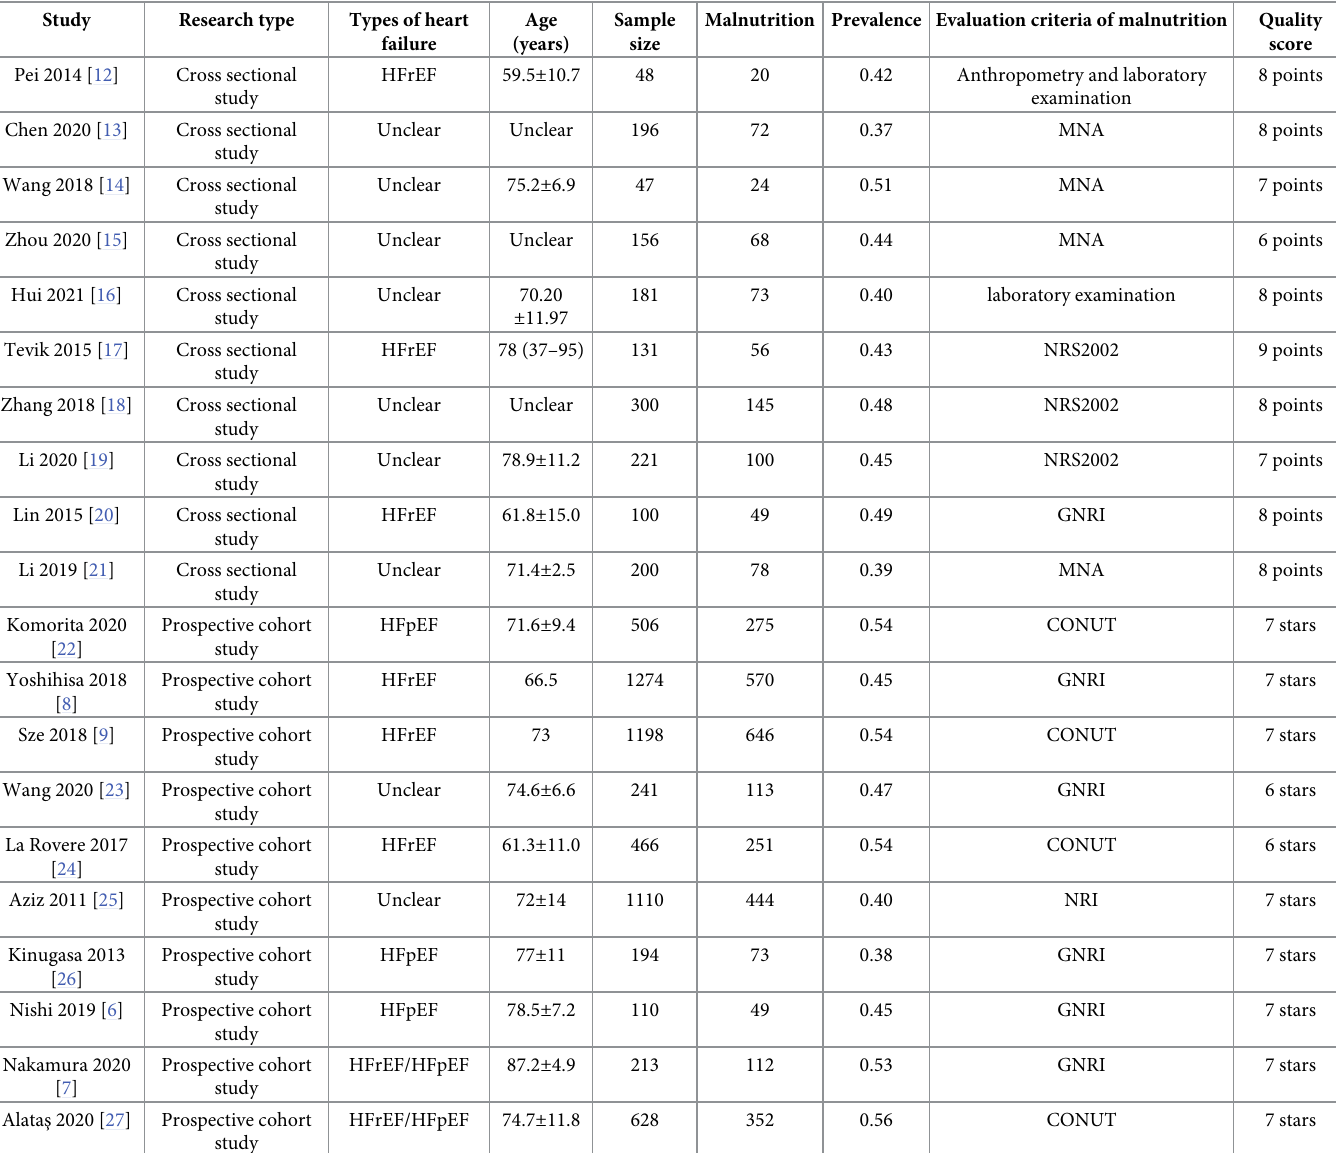
Table 1. Basic information of included literatures: Prevalence of